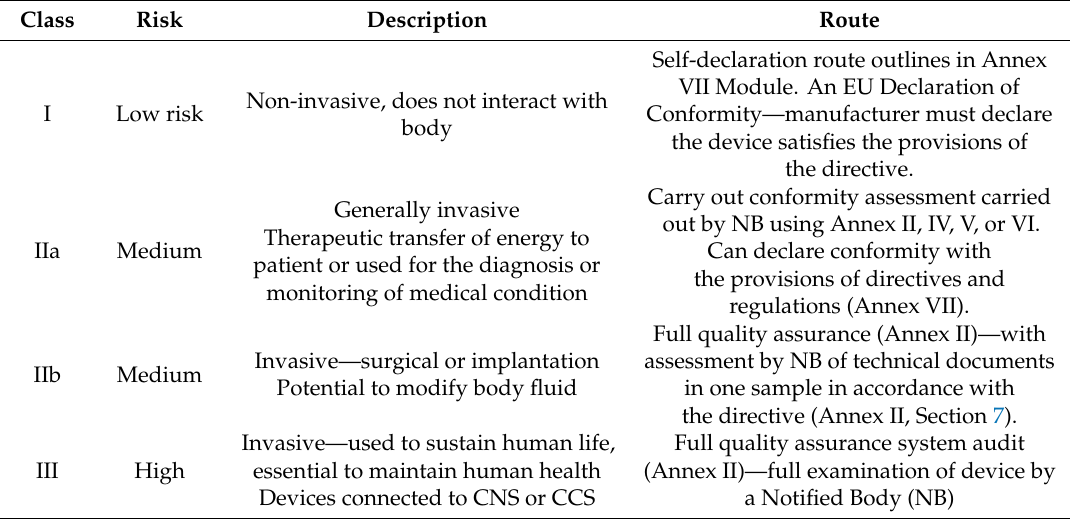
Table 3 [136]. Nebulizers are the only general purpose, non-paired device on the list of aerosol generators. pMDI, DPI, and SMI are themselves part of a drug–device combination. General-purpose nebulizers are considered Class II. Table 3. Product classification and routes for the authorization of medical devices within the EU